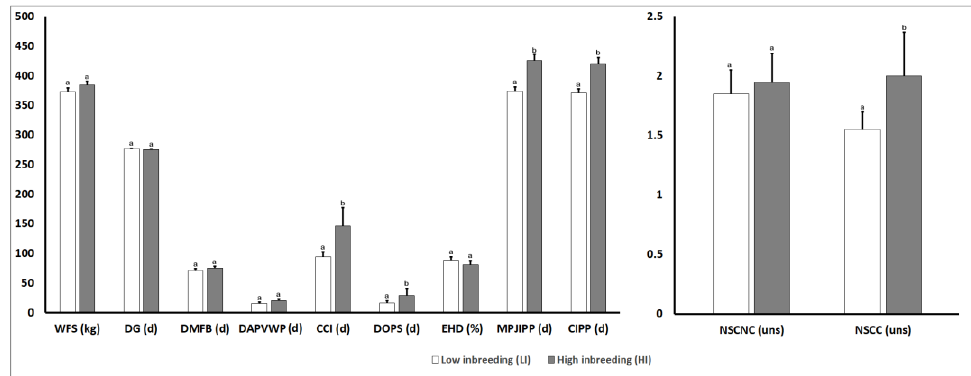
Figure 5. Effect of the degree of inbreeding (LI and HI) on phenotypic parameters for reproductive traits in high producing primiparous dairy cows. Reproductive phenotypic values: WFS: Weight at